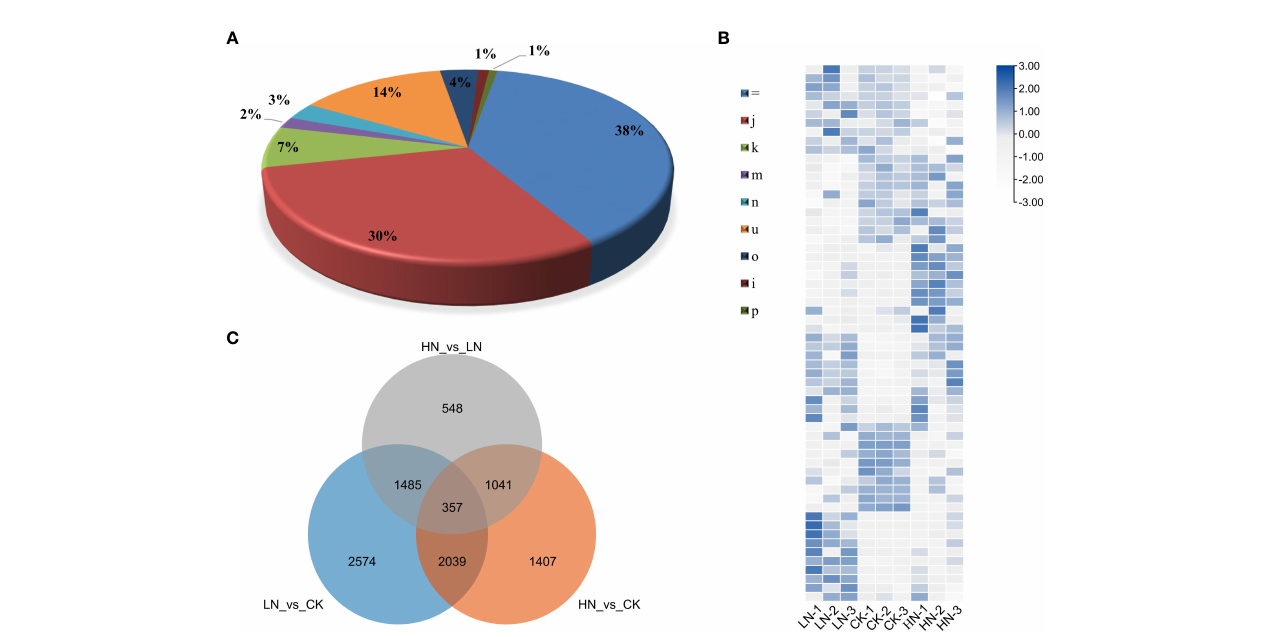
FIGURE 2 (A) Compare the category code generated by CuffCompare with the tea plants genome, and then calculate the percentage. “ = “ : complete, exact match of intron chain; “ j ” : multi-exon with at least one junction match; “ k ” : containment of reference (reverse containment); “ m ” : retained intron (s), all introns matched or retained; “ n ” : retained introns (s), not all introns matched/covered.; “ u ” : none of the above (unknown, intergene); “ o ” : other same strand overlap with reference exons; “ i ” : fully contained within a reference intron; “ p ” : possible polymerase run-on (no actual overlap). (b~c) Analysis of transcripts in LRs (lateral roots) of tea plant under three nitrogen treatments, LN, CK and HN, with three replicates for each. (B) Cluster heat map of DE- lncRNAs (differentially expressed lncRNAs) in three treatments. (C) Venn diagram of common